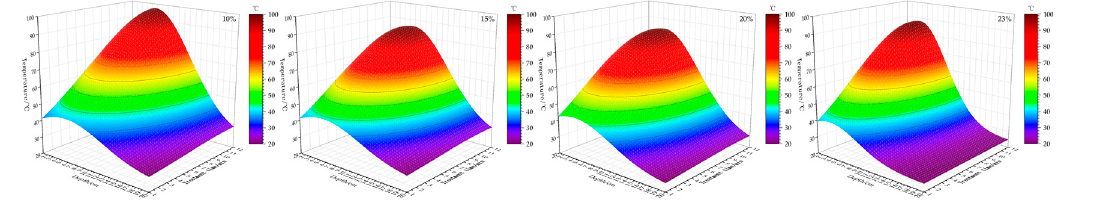
Figure 29. Fitting surface of black soil internal temperature with irradiation time and soil depth. Table 3. Surface fitting equation of the change in the internal temperature ⎯ T n of the soil layer with the irradiation time and soil depth (“irradiation time–soil depth” temperature fitting surface equation, the number after “±” represents the parameter range).